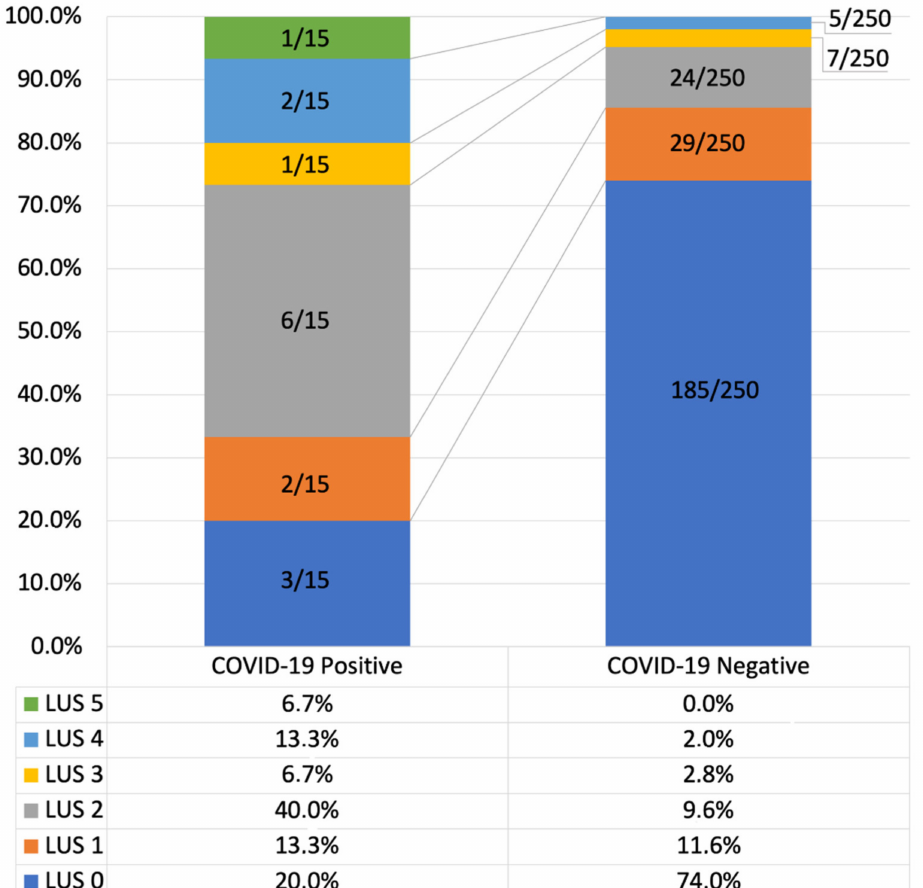
Figure 3. Total Lung Ultrasound Score (LUS) in COVID-19 positive and negative subjects. In the COVID-19 positive group, despite subjects were not at all or poorly symptomatic, the rate of normal lung ultrasound appearance markedly dropped, to 20% (3/15). 80% (12/15 subjects) showed some abnormalities: LUS 1 was present in 2 subjects, (13.3%), LUS 2 in 6 subjects (40%), LUS 3 in 1 subject (6.7%), LUS 4 in 2 subjects (13.3%) and LUS 5 in 1 subject (6.7%) (Figure